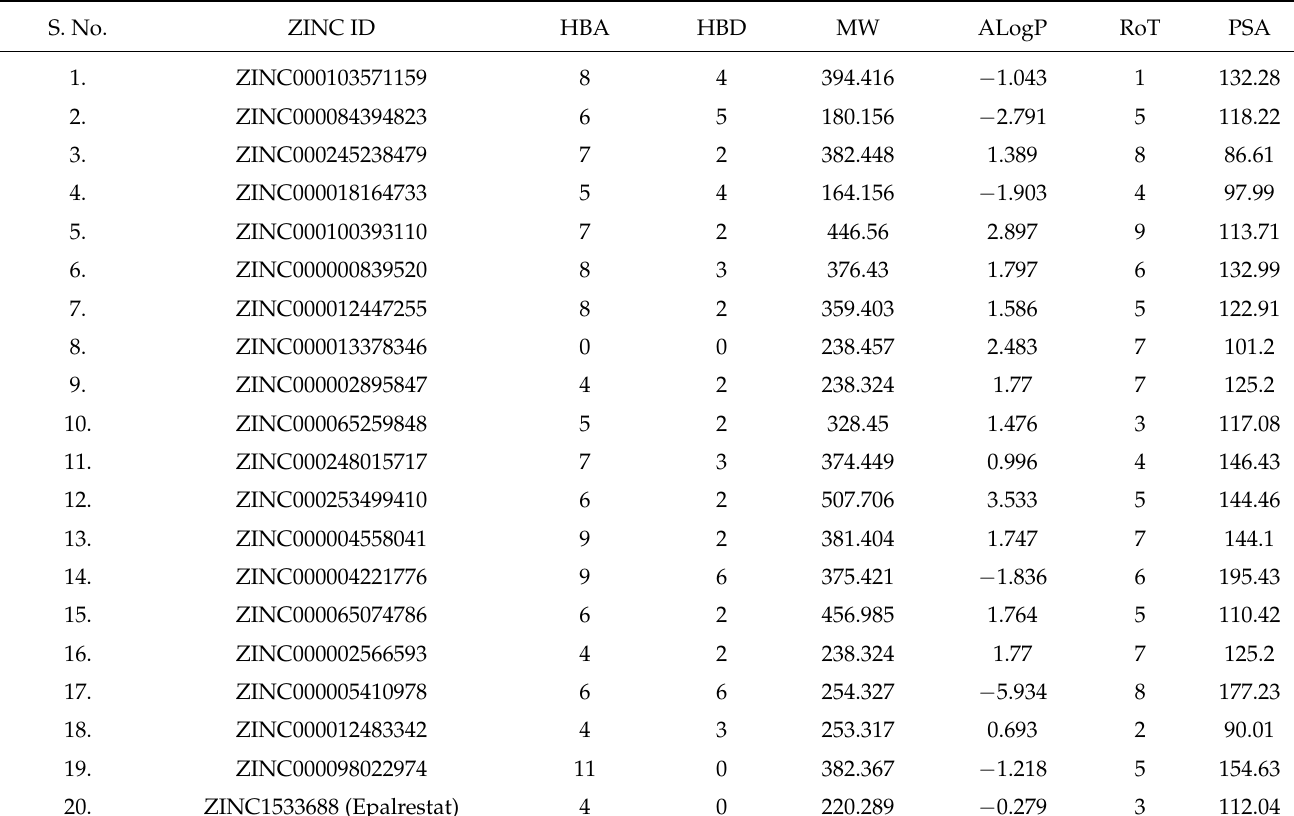
Table 3. Drug-likeness properties of the